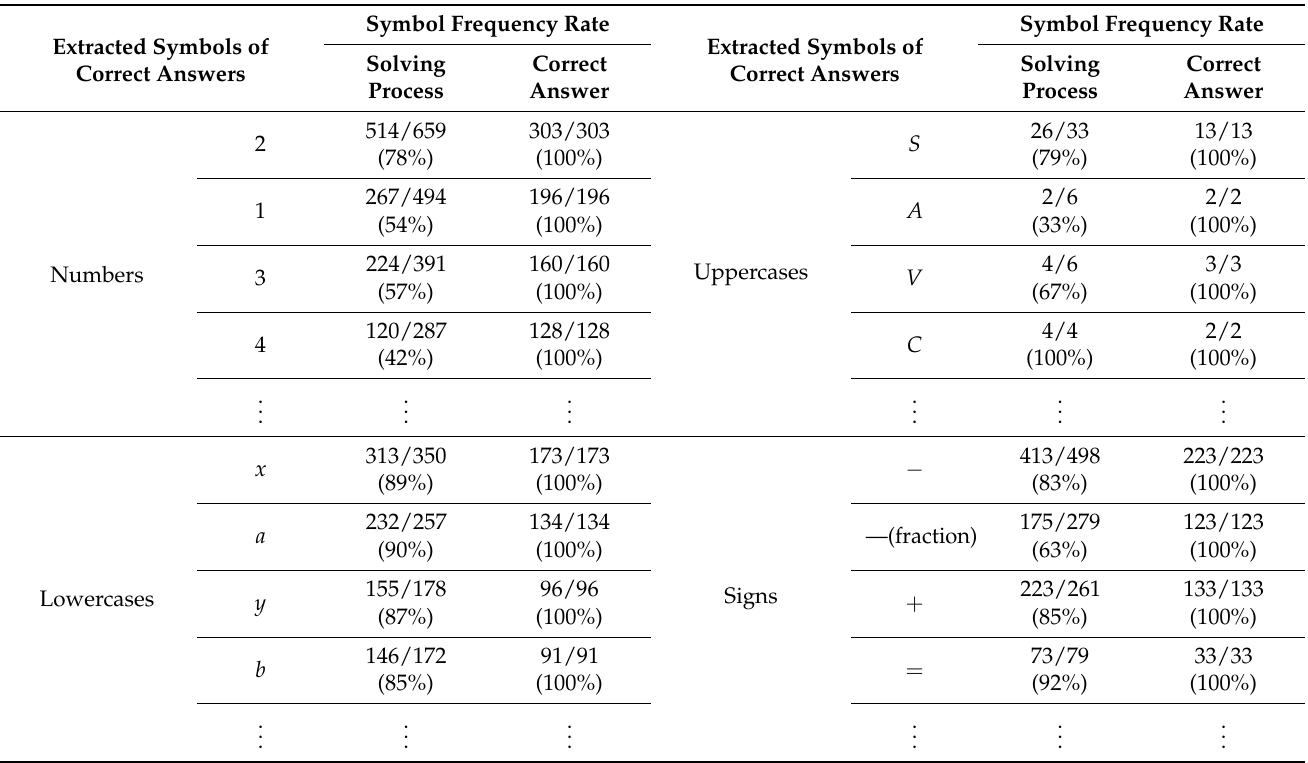
Table A6. Sample Symbol Frequency Rates in Solving Processes and Correct Answers for Symbols Extracted from Correct